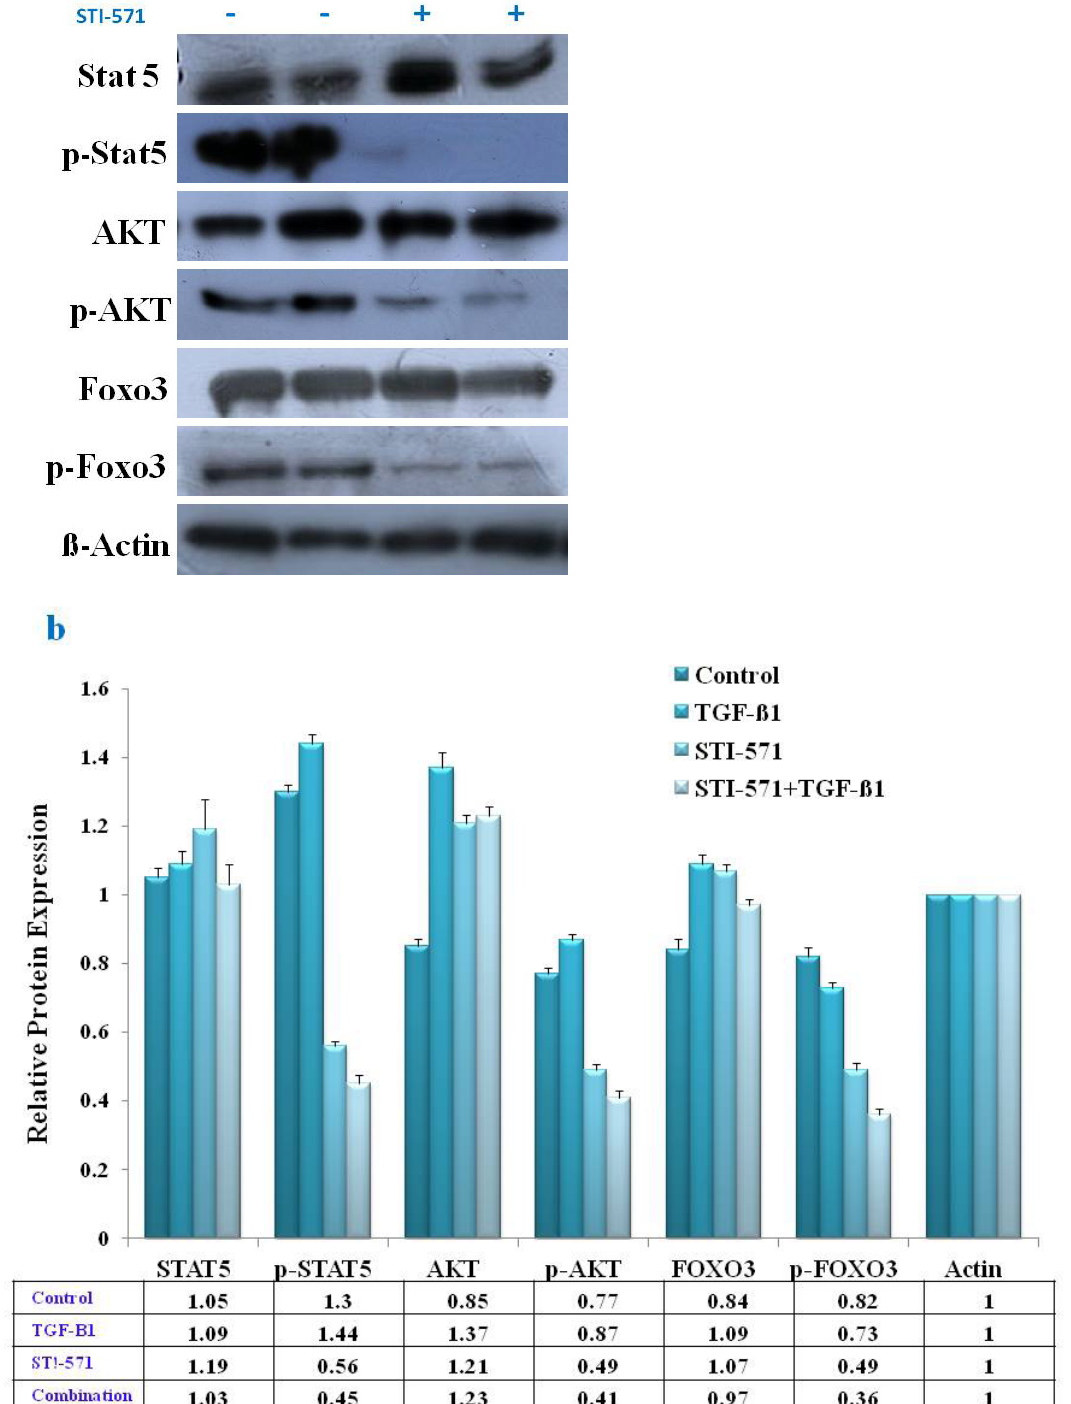
Figure 3a) Protein expression and phosphorylation levels of AKT, p-AKT, Stat5, p-Stat5, FOXO3, and p-FOXO3 proteins in K562 cells treated with 2 ng/mL of TGF-β1 and 0.5 µM STI-571, individually and in combination, for 48 h. Combination therapy with TGF-β1 was associated with a lower phosphorylation level than treatment with TGF-β1 individually. b) Data represented as mean± SD, and quantitative expression of proteins was normalized to the level of ß-actin. The results showed a significant difference in treated groups compared to other groups (P <